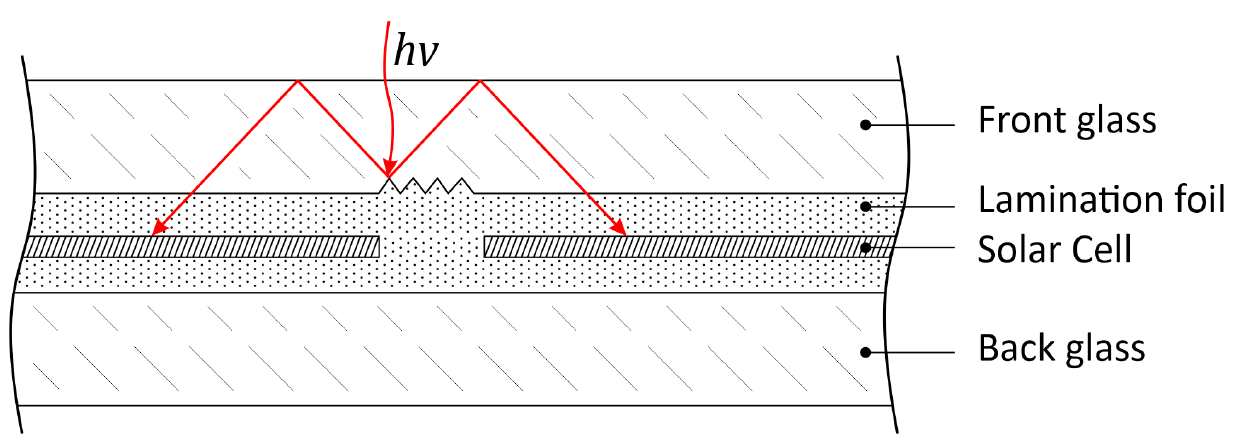
Figure 1. Model of the module with a diffuser placed in the inactive (intercell) space of the module.